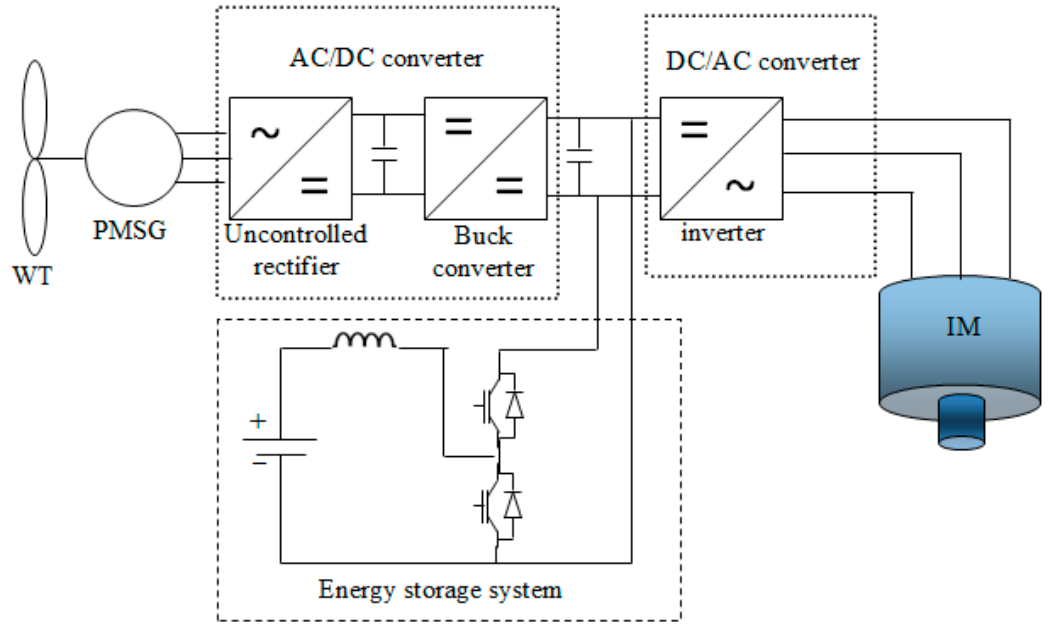
Figure 1. Illustration diagram of the suggested autonomous WEC framework. Reproduced from Kassem [18], IET Renewable Power Generation: 2016.